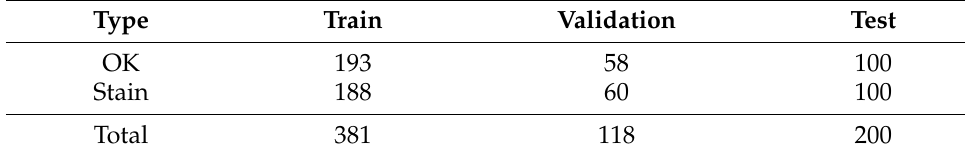
Figure 6. Magnetic Tile Dataset ( Left : image, Right : Stain Defect segmentation image). Table 2. Magnetic tile